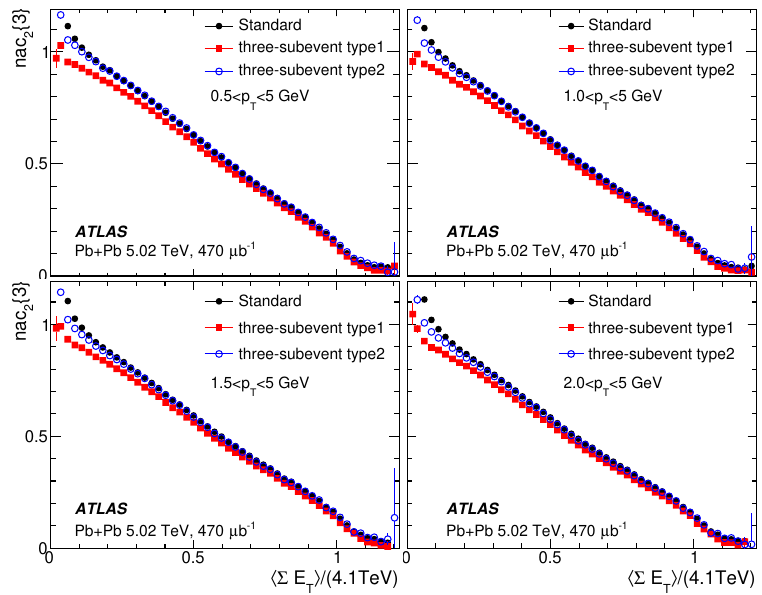
Figure 32 . The nac 2 f 3 g from the standard method (solid circles), three-subevent method with V 4 de(cid:12)ned in subevent a or c (solid squares) and three-subevent method with V 4 de(cid:12)ned in subevent b (open circiles). Di(cid:11)erent panels correspond to di(cid:11)erent p T ranges. Only statistical uncertainties are shown.